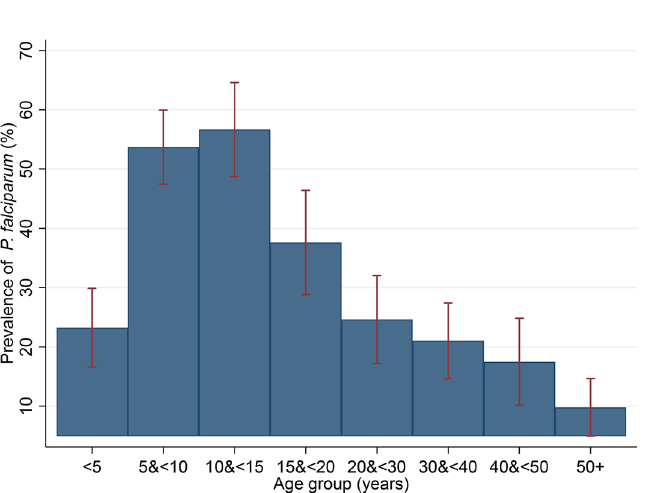
Figure 2. Prevalence of P. falciparum infection by age group in study population. Error bars are 95% confidence